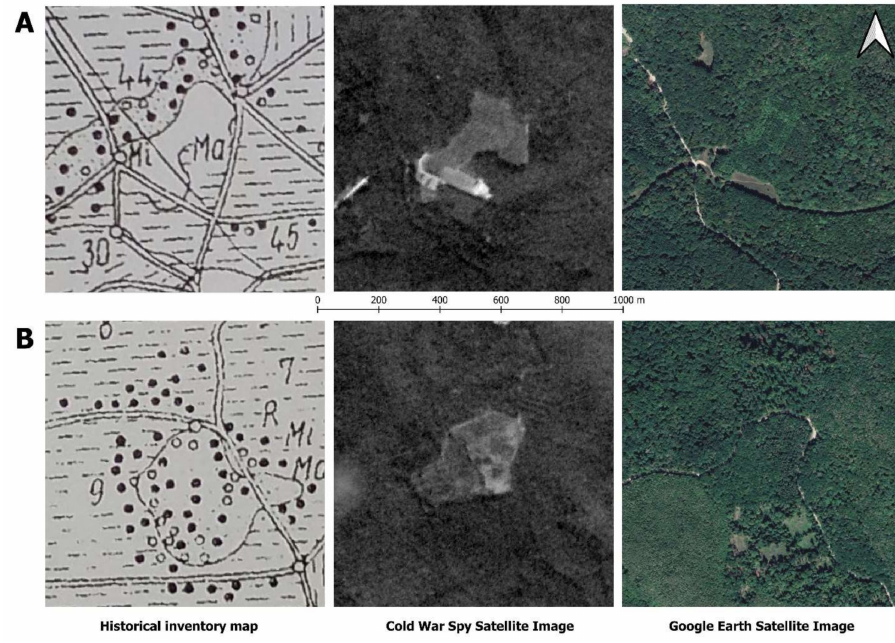
Figure 7. Comparison of maps/images from different times (left = original hand-drawn map from 1960; middle = Corona spy-satellite image from 1960s; right = Google Earth satellite image). ( A )—area formerly open in the 1960s, with clear edge and presence of nests nearby, inside the neighboring stand. At present closed, with very little edge left. ( B )—former young, open canopy, conifer plantation in the 1960s. Now closed canopy, tall stand (no edges, no